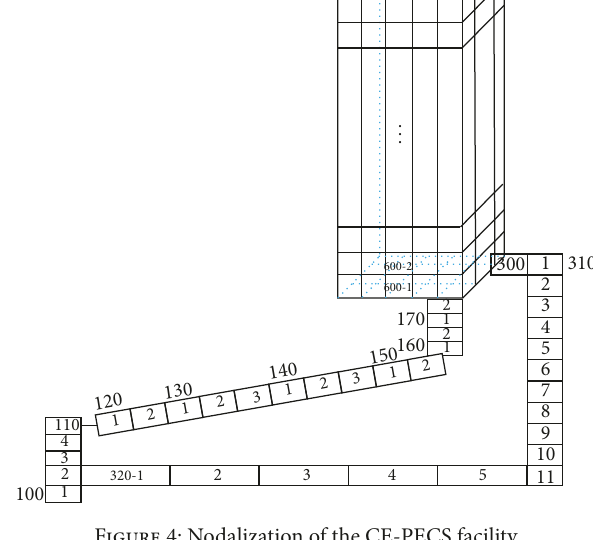
Figure 4: Nodalization of the CE-PECS facility.